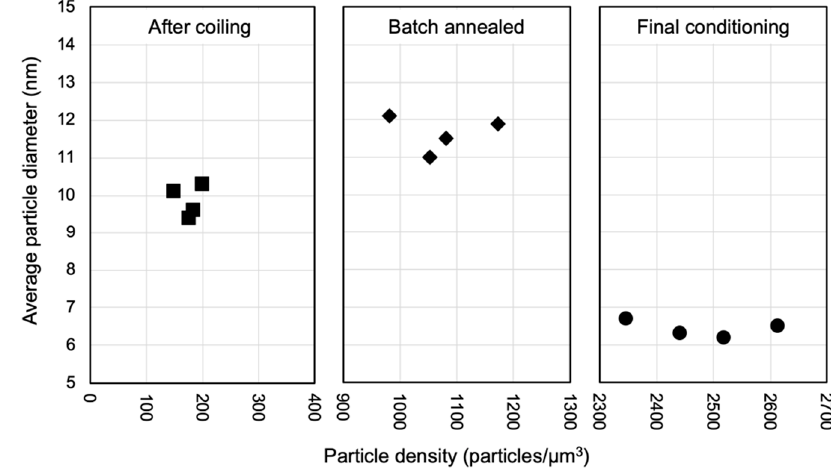
Figure 10. Size and particle density analysis of niobium precipitates for the different processing conditions at four strip positions. Table 3. Quantitative evaluation of Nb precipitates at various processing stages (average values).